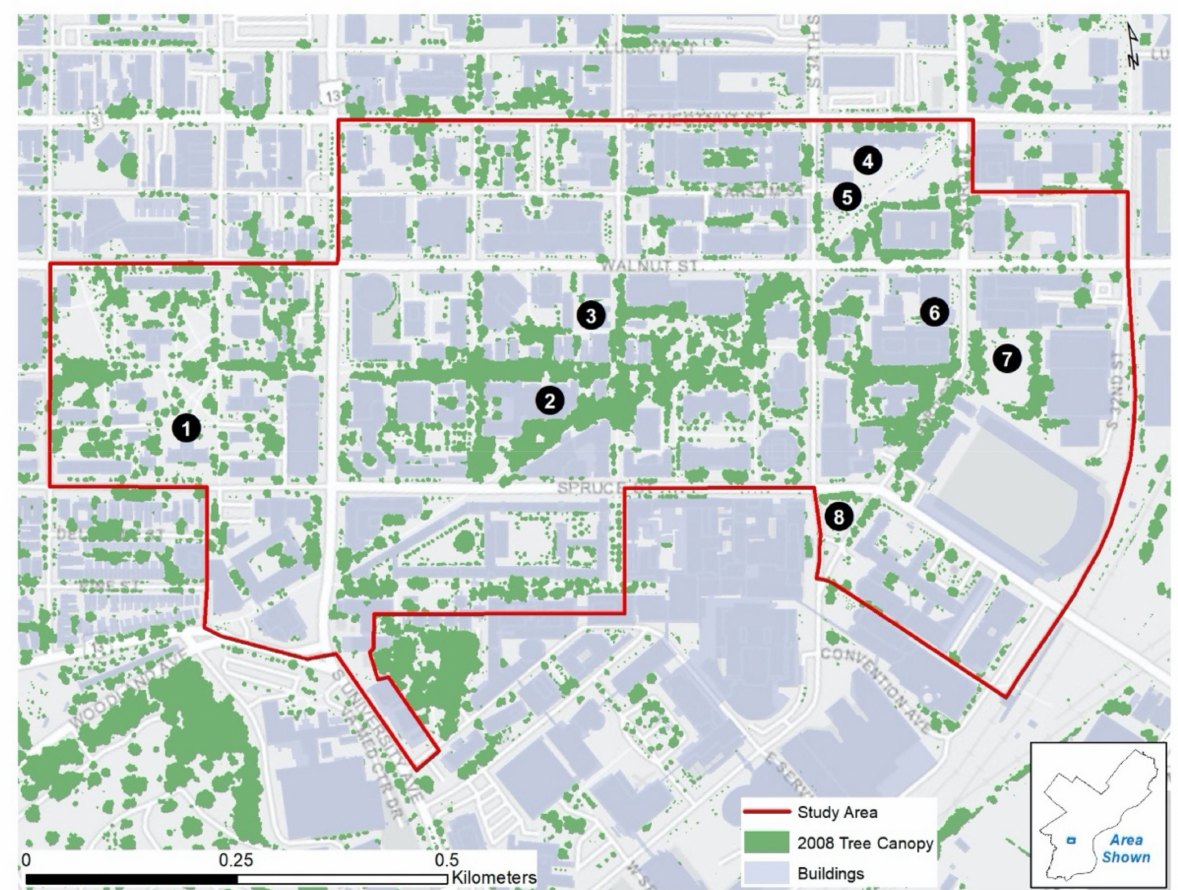
Figure 1. The University of Pennsylvania campus, displaying the core campus area used in this study. Numbers indicate places discussed in the text: ( 1 ) Harrison College House, ( 2 ) Steinberg-Dietrich Hall, ( 3 ) Annenberg Public Policy Center, ( 4 ) New College House, also known as Lauder College House, ( 5 ) McNeil Center for Early American Studies, ( 6 ) Skirkanich Hall, ( 7 ) Shoemaker Green, and ( 8 ) Edward W. Kane